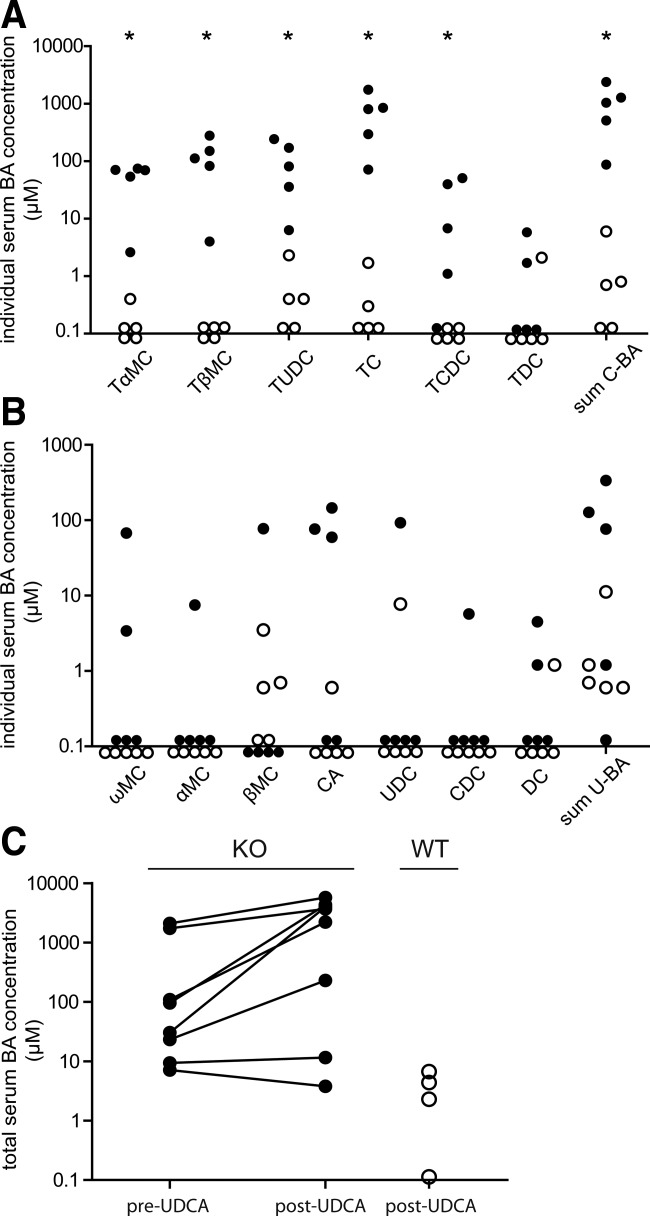
Effects of BA supplementation on serum BA concentrations. After 4 days of 0.1% UDCA supplementation, serum composition of (A) conjugated and (B) unconjugated BA species was measured in 5-week-old WT (open dots) and Slc10a1−/− (black dots) mice. Data are given as a scatter plot on a 10log scale from five mice in each group. *P < 0.05. (C) Total serum BA levels were measured before starting 0.1% UDCA supplementation (pre-UDCA) and after 1 week (post-UDCA) in 8- to 10-week-old Slc10a1−/− mice (black dots). As a control total serum BA levels of WT mice (open dots) were measured after 0.1% UDCA supplementation. Data are given on a 10log scale from four WT and eight Slc10a1−/− mice.